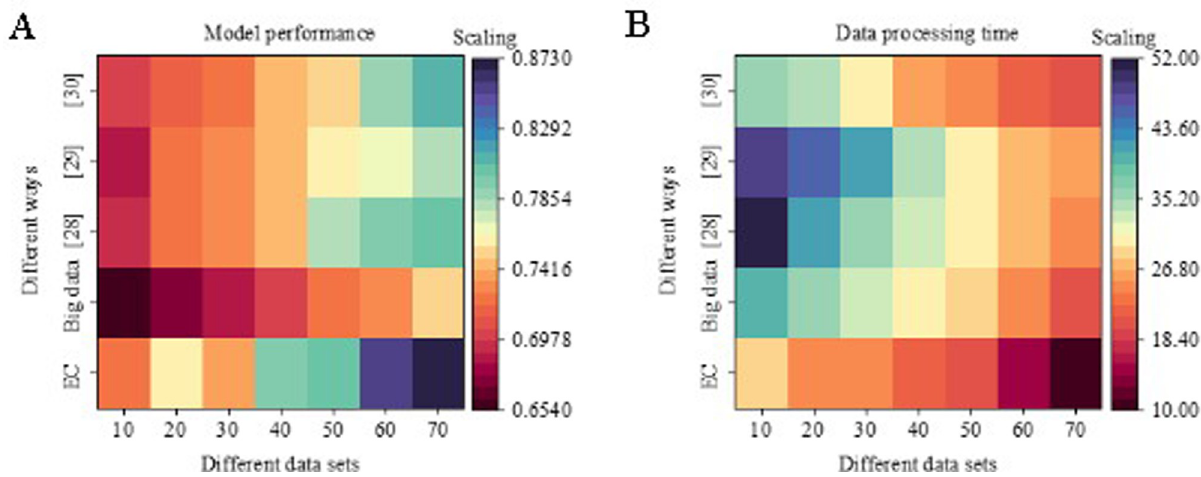
Fig 9. Analysis results of the cloud computing processing